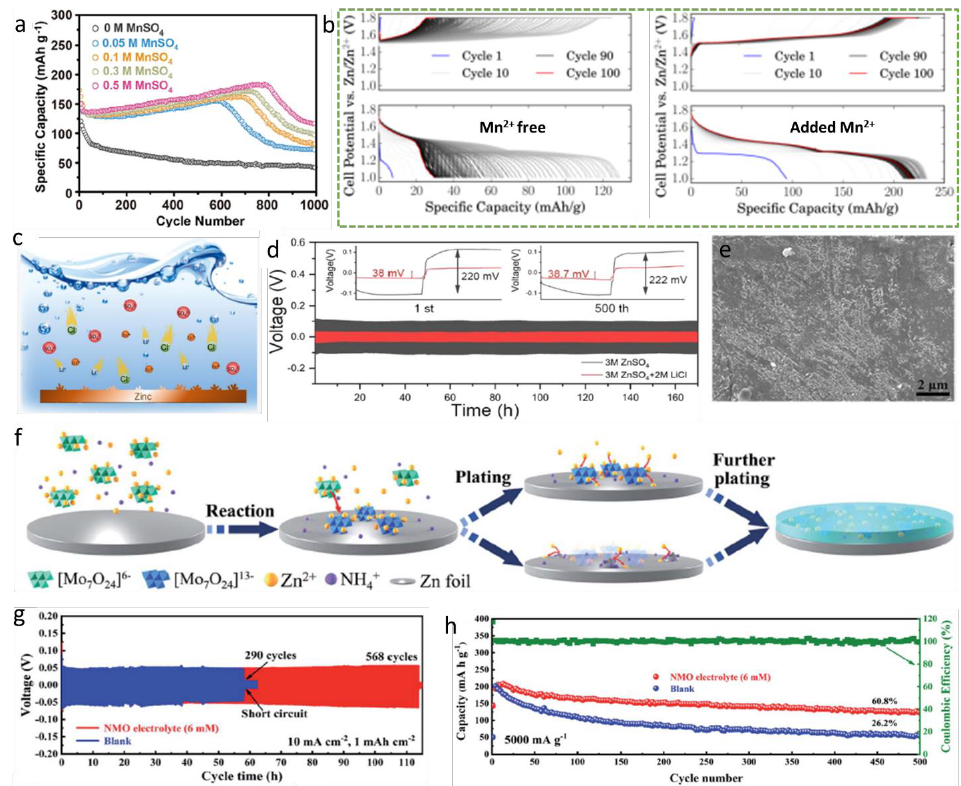
Figure 14. ( a ). Cycle performances of the Zn ǁ MnO 2 cells using different electrolytes for 1000 cycles at a current density of 200 mA g − 1 (Reproduced with permission. [154] Copyright 2020, Elsevier). ( b ) Discharge curves of MnO 2 electrodes in Mn 2+ free and added Mn 2+ electrolytes at 60 mA g − 1 (Repro- duced with permission. [156] Copyright 2018, Elsevier). ( c ) Illustration of LiCl additive inhibiting dendrite growth and stabilizing Zn anode, ( d ) galvanostatic charge – discharge curve under the cur- rent density of 0.2 mA cm − 2 , and ( e ) SEM of Zn electrode after 500 cycles with 3 M ZnSO 4 + 2 M LiCl (Reproduced with permission. [162] Copyright 2021, American Chemical Society). ( f ) Schematic il- lustration of Zn deposition with polyoxometalate additive, ( g ) cycling performance of Zn symmetric cells using electrolytes without or with polyoxometalate additives at 10 mA cm − 2 and 1mAh cm − 2 , and ( h ) long-term cycling performance of the Zn ǁ NaV 3 O 8· 1.5H 2 O full cells with or without polyox- ometalate additive at 5000 mA g − 1 (Reproduced with permission. [164] Copyright 2021, Royal Soci- ety of Chemistry).